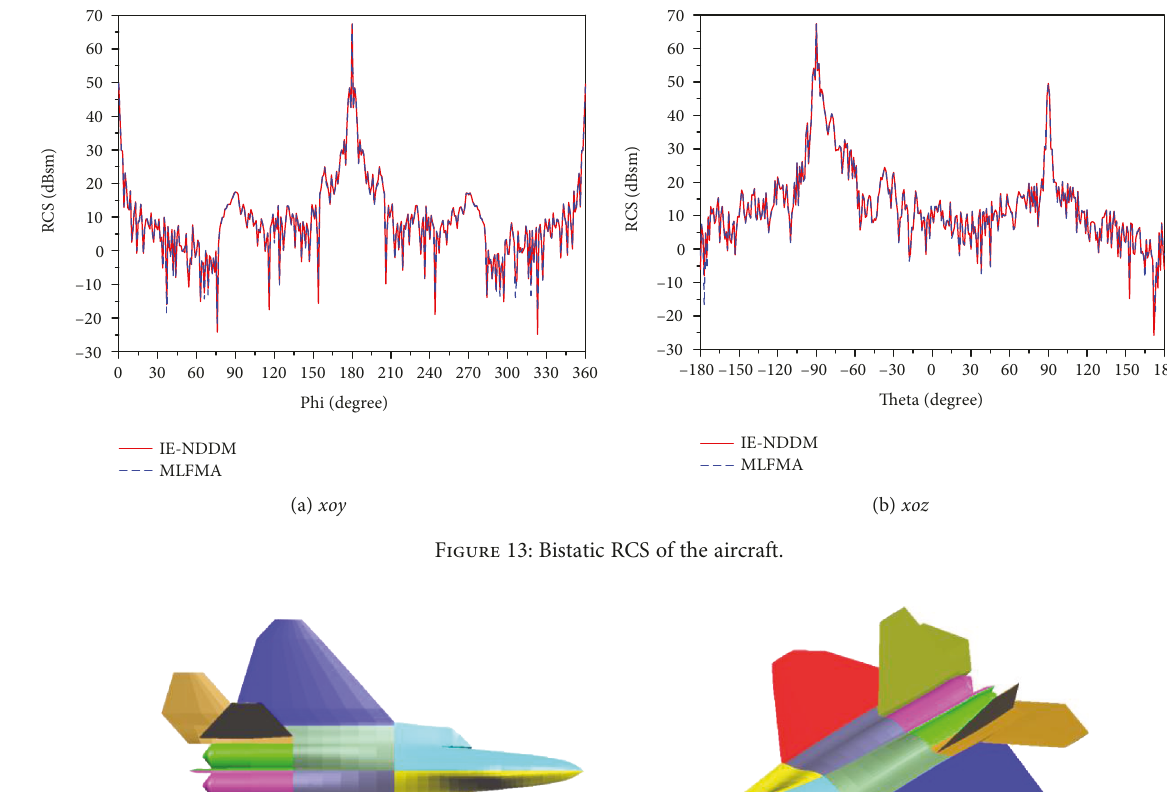
Figure 14: Model of the aircraft divided into ten